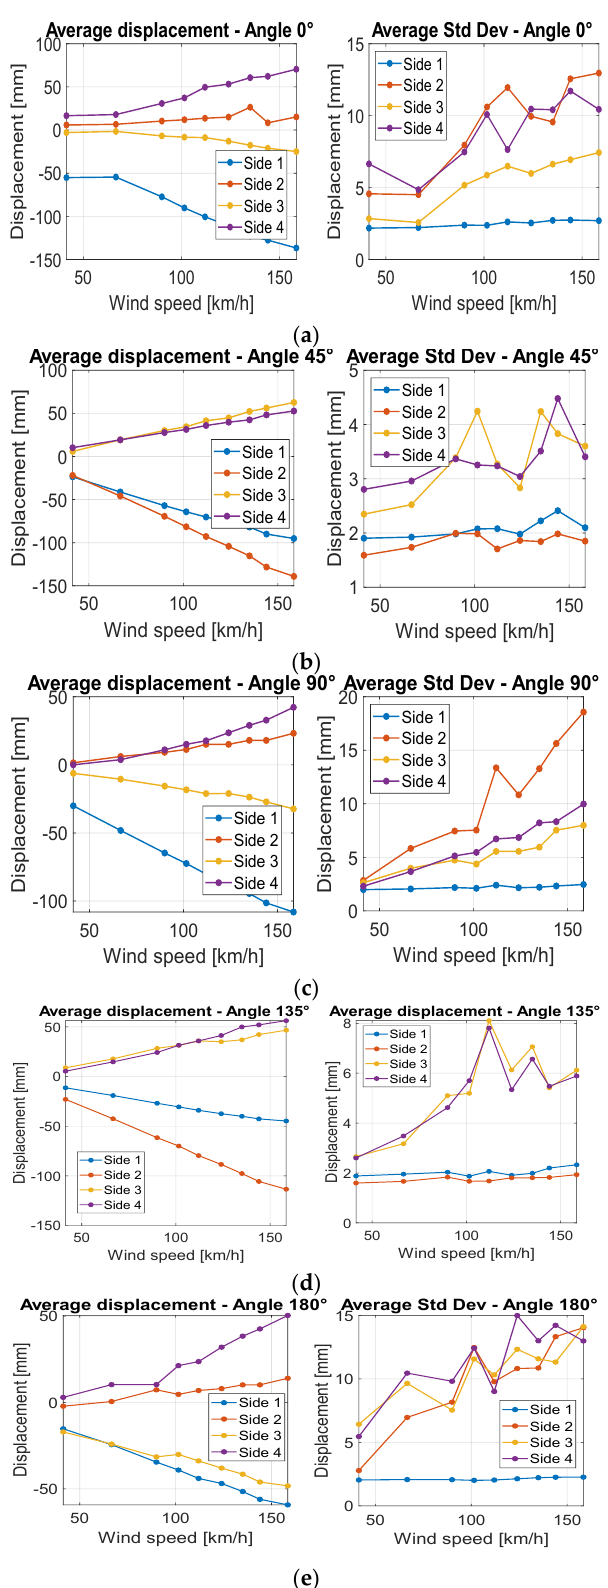
Figure 12. Average displacements and the standard deviation for each side of the squared base structure at 1/2 of the total height for different wind velocities for angles 0 ◦ ( a ), 45 ◦ ( b ), 90 ◦ ( c ), 135 ◦ ( d ), 180 ◦ ( e